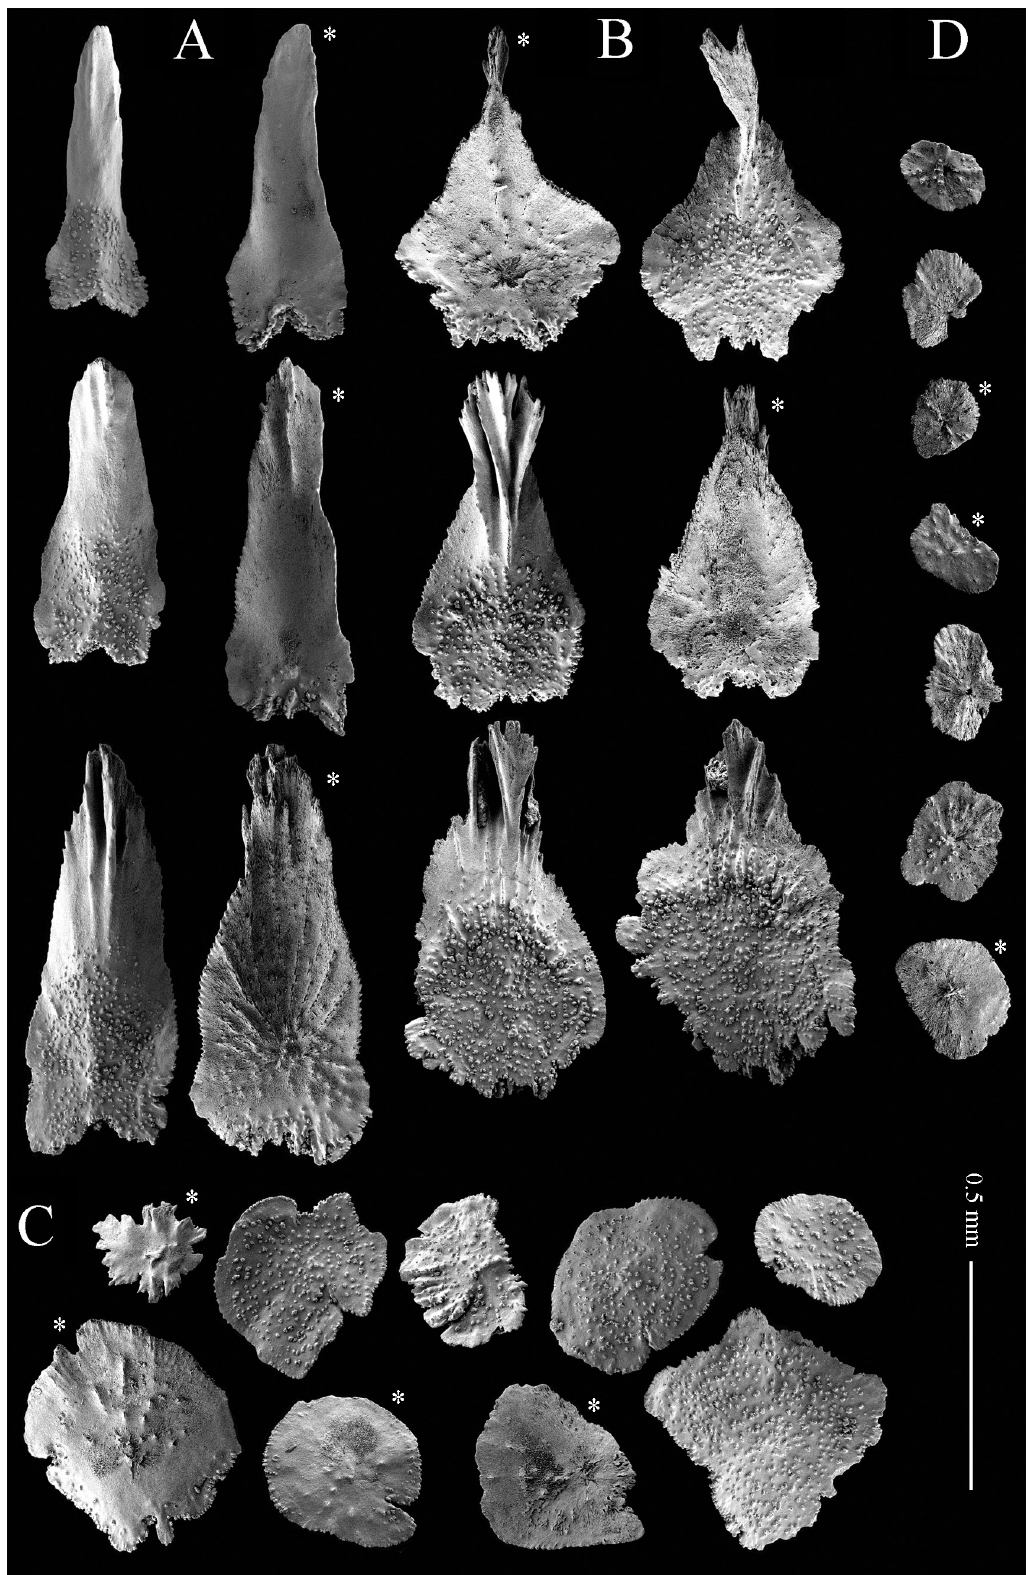
Fig . 9. – Thouarella dispersa Kükenthal, 1912, holotype (ZMB Cni 5468): A, opercular scales; B, marginal scales; C, body scales; D, coe- nenchymal sclerites. [ * outer surface